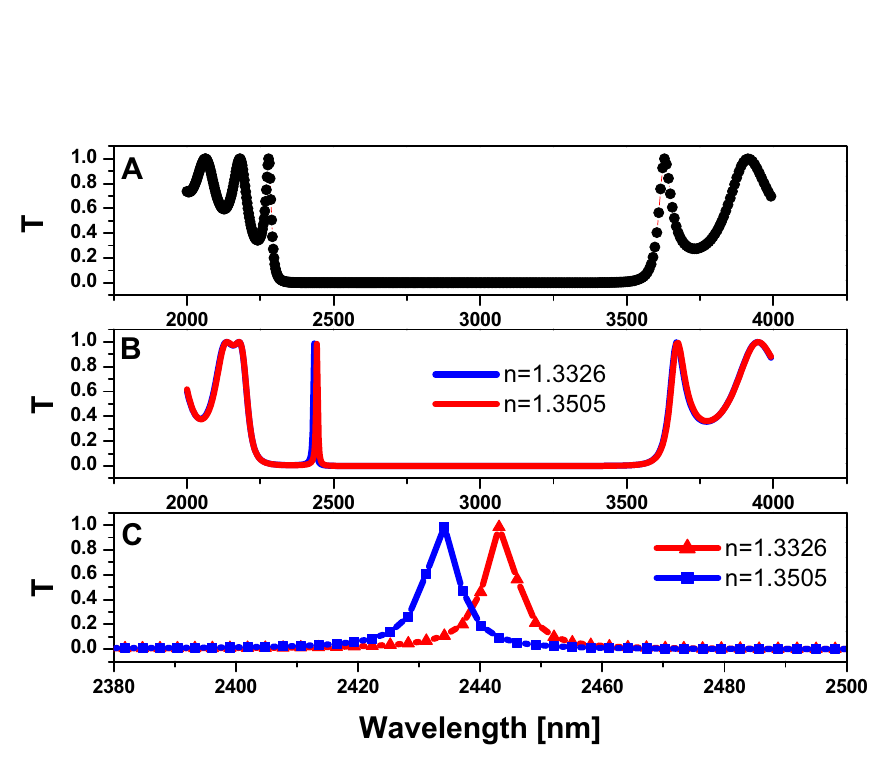
Figure 10. Transmission property of two-dimensional hexagonal cylinder unit cell with R = 500nm D = 250nm , N = 5, and the host material is titanium dioxide ( TiO 2 ) . ( A ) All cylinders are filled with air; ( B ) All cylinders are filled with air except for the centred pour, which is filled with saline water with varying refractive index values; and ( C ) zoom in on the defect peak in figure ( B